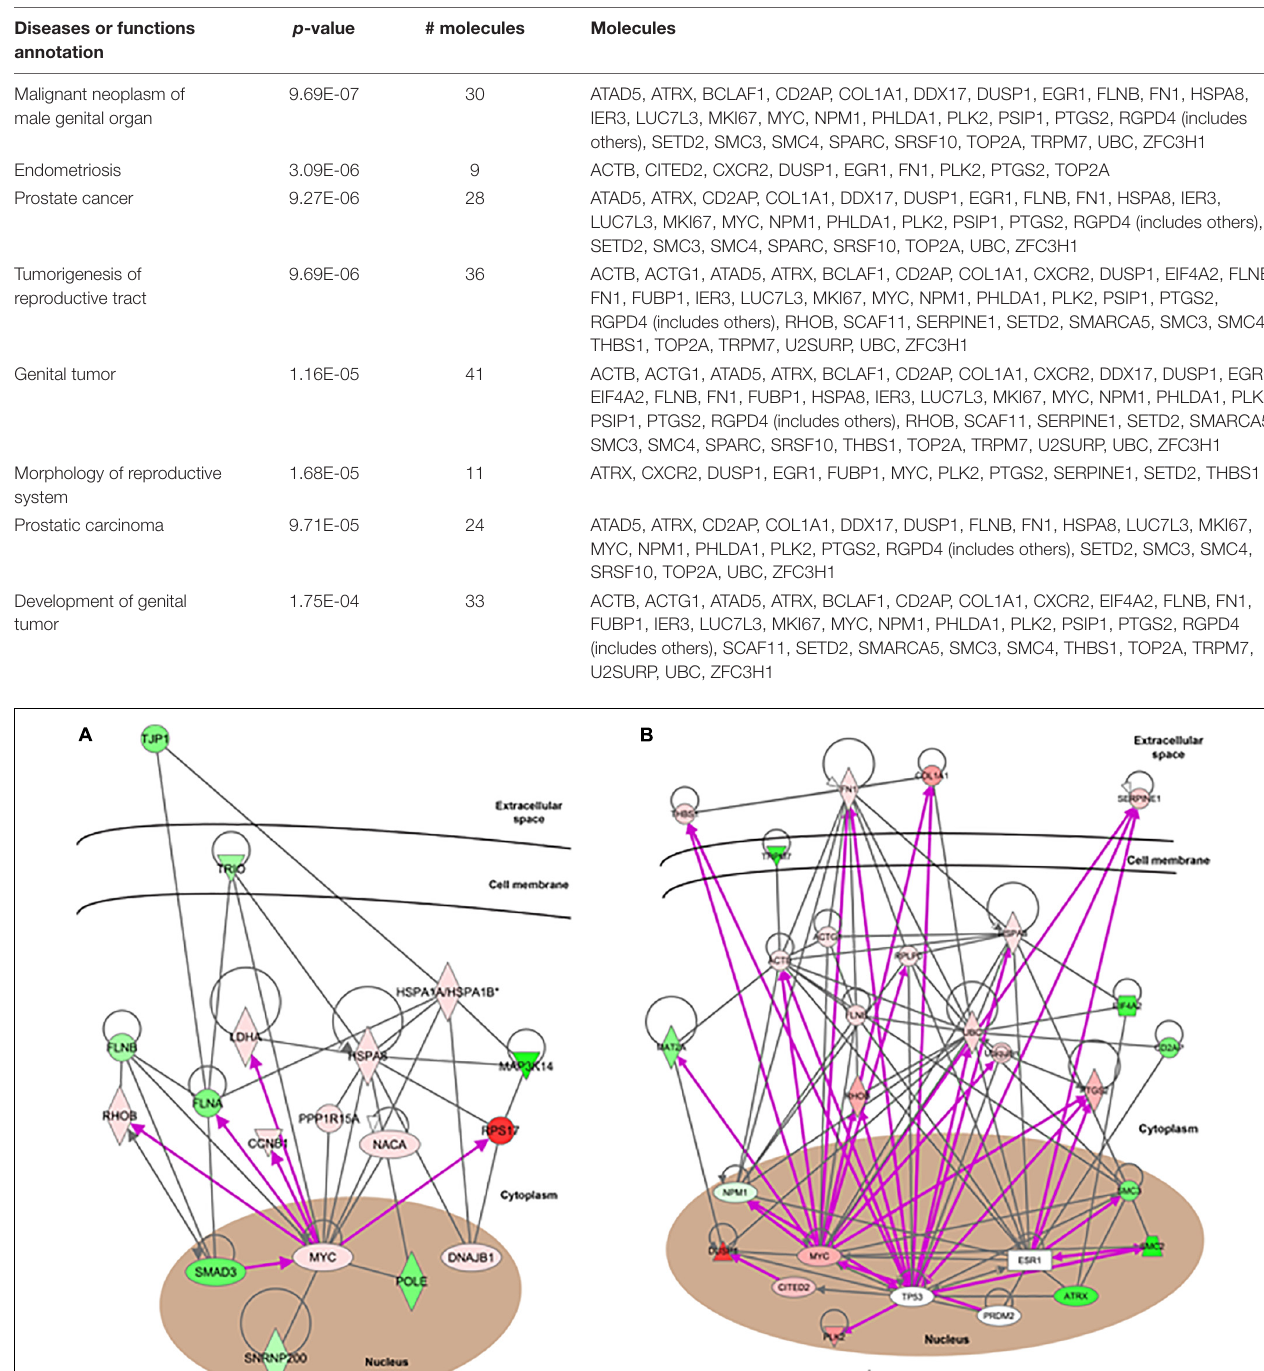
TABLE 9 | Male reproductive diseases caused by radiation exposure.